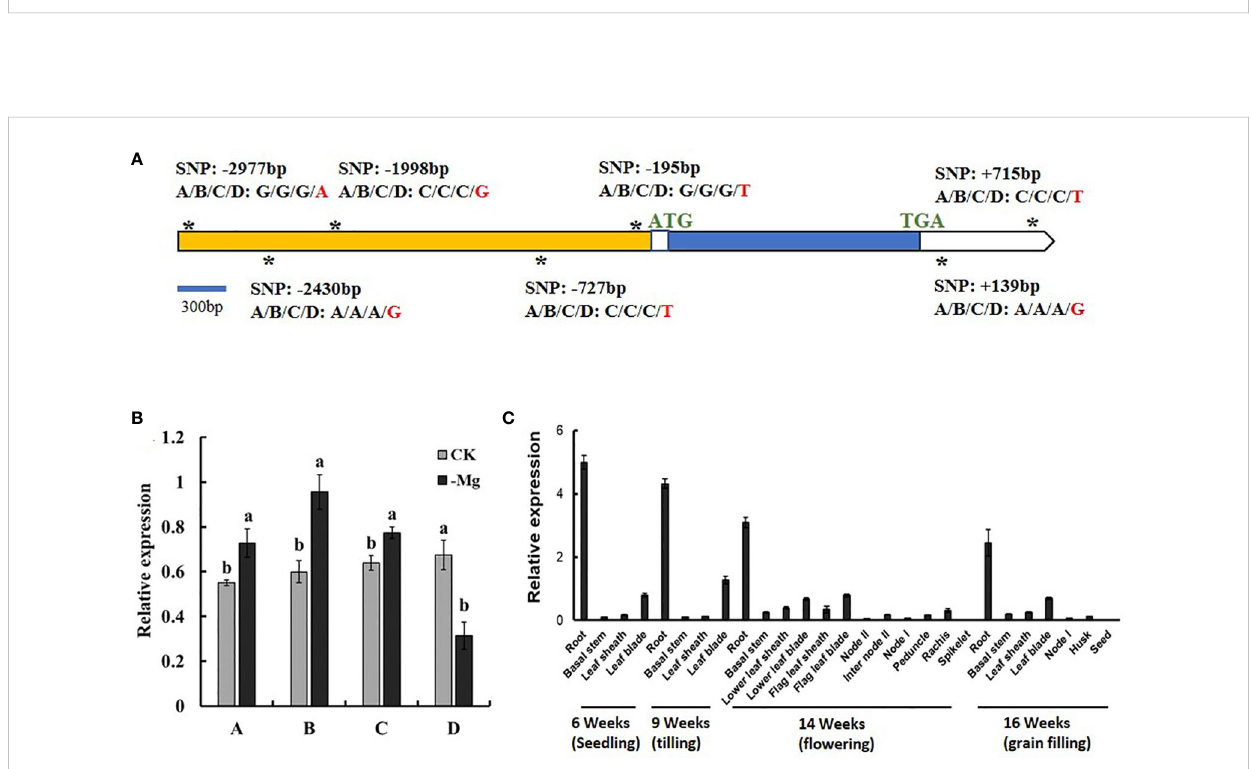
FIGURE 6 Sequence and expression of LOC_Os03g04360 in the four parental lines of the DC1 population. (A) Gene structure of LOC_Os03g04360 and polymorphism locations (SNPs, asterisks). The SNPs are underlined with asterisks. (B) Relative expression of LOC_Os03g04360 under different Mg 2+ concentrations. The rice seedlings grown in the 1/4 strength IRRI solution for two weeks, and in the full strength IRRI solution with 1 mM Mg 2+ (CK) or without Mg 2+ (-Mg) for three weeks. RNA was extracted from rice roots. (C) Expression of LOC_Os03g04360 in different organs at different growth stages. RNA Samples were taken from cv. Nipponbare grown in a paddy fi eld. Values are mean ± SE (n = 3). The different letters above the bars indicate signi fi cant difference between the control and treatments at P <